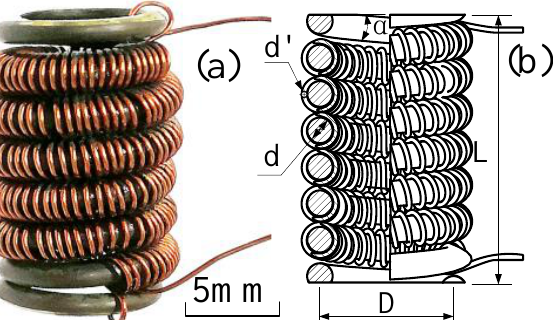
Figure 10. Schematic diagram of electrothermal SMA spring. ( a ) Sample diagram and ( b ) principal diagram.